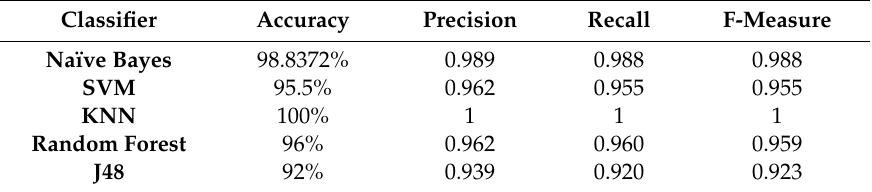
Table 1. Performance metrics for TX–RX (Transmitter–Receiver) of 10 cm features (632 features per case).